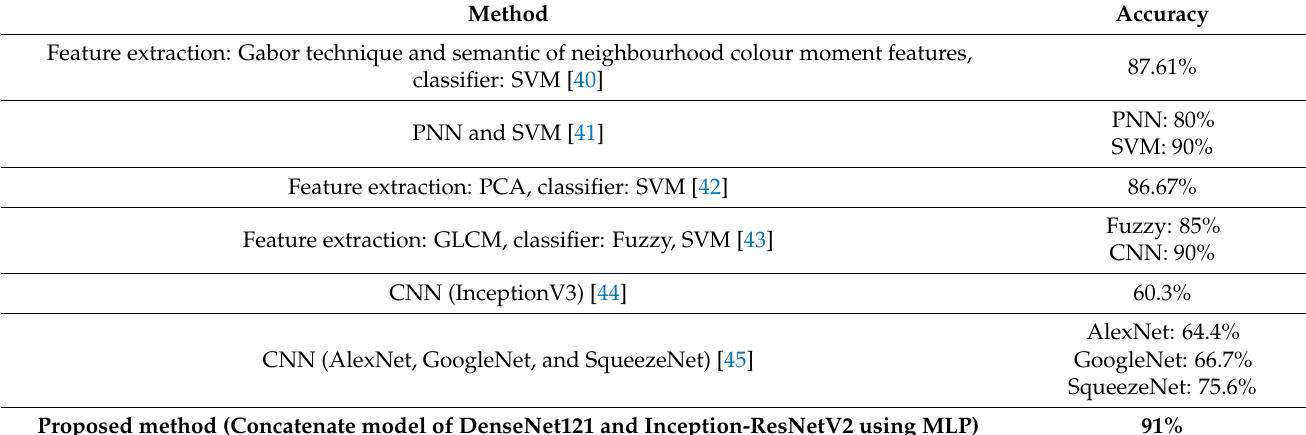
Table 10. The comparison of model performance using three classes (no DR, NPDR, and PDR) with other